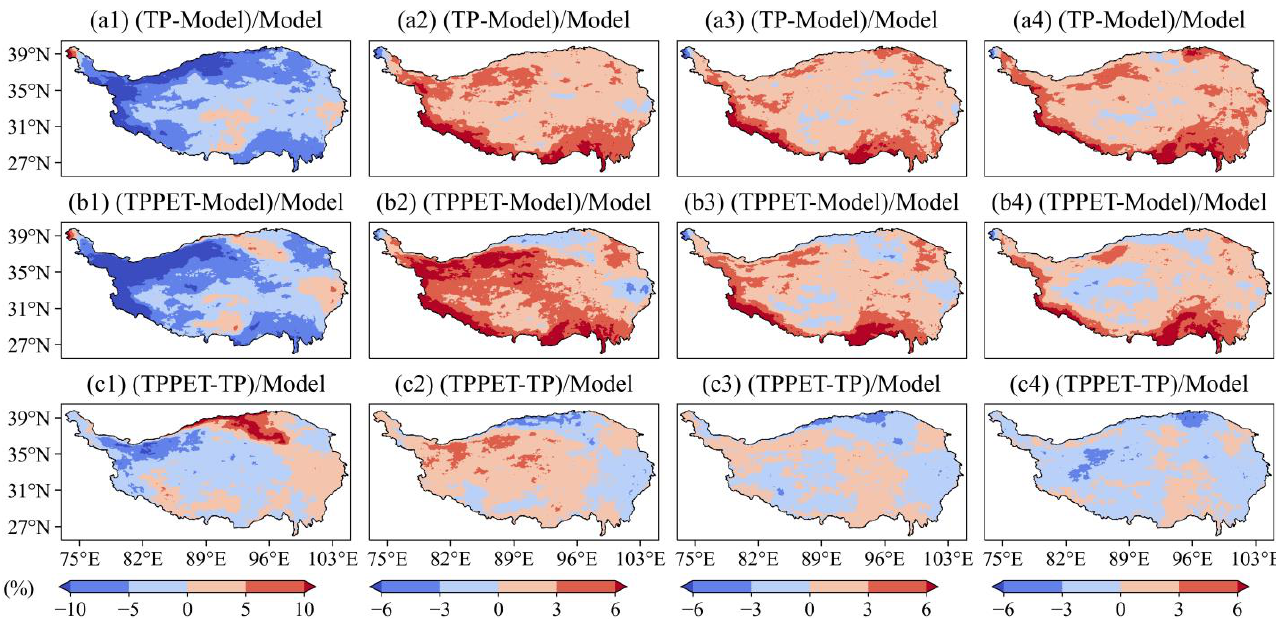
Figure 9. Spatial differences of drought intensity in different SPEI. ( a – c ) are, respectively, the difference between intensity (uncorrected) and intensity (only TP corrected), intensity (uncorrected) and intensity (TP and PET corrected), and intensity (only TP corrected) and intensity (TP and PET corrected). ( a1 – a4 ) are historical, SSP1-2.6, SSP2-4.5, and SSP5-8.5 scenarios,